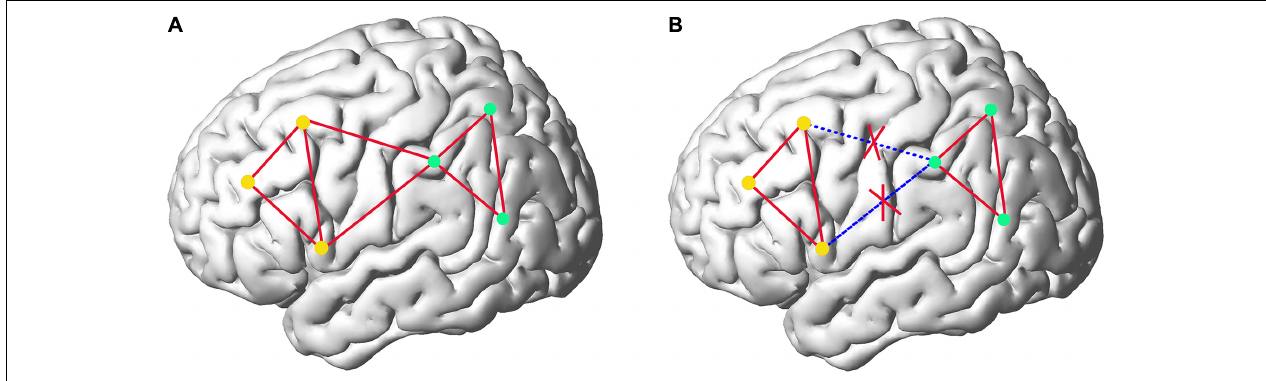
FIGURE 1 | The comparison of the FC information captured in fully network (A) and sub-network (B) of brain. The dots represent ROIs and the red lines represent FCs. Yellow dots and green dots depict two different sub-networks.